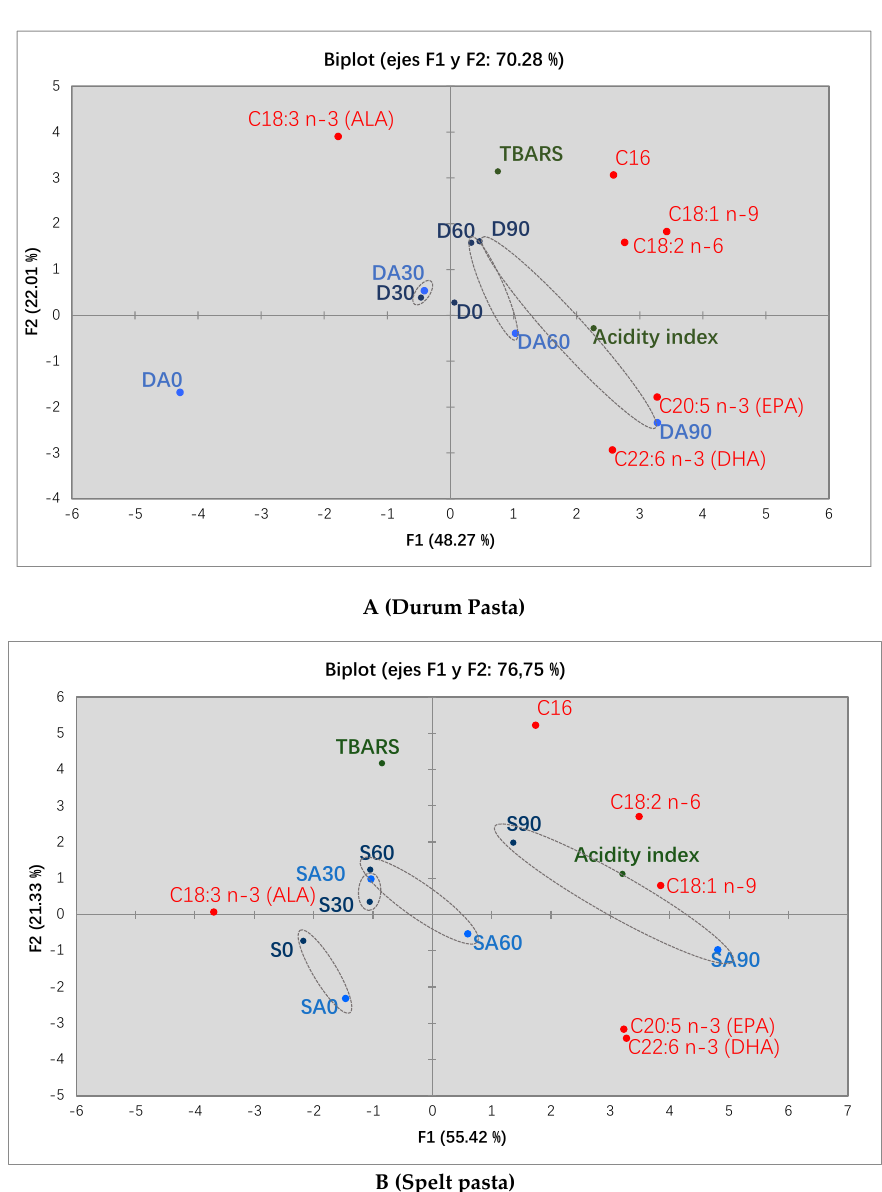
Figure 2. Principal Component: Analysis of developed pasta with and without antioxidant added over storage time. D0: Durum F day 0, D30: Durum F day 30, D60: Durum F day 60; D90: Durum F day 90, DA0: Durum F + antioxidant day 0, DA30: Durum F + antioxidant day 30, DA60: Durum F + antioxidant day 60, DA90: Durum F + antioxidant day 90. S0: Spelt F day 0, S30: Spelt F day 30, S60: Spelt F day 60; S90: Spelt F day 90, SA0: Spelt F + antioxidant day 0, SA30: Spelt F + antioxidant day 30, SA60: Spelt F + antioxidant day 60, SA90: Spelt F + antioxidant day 90. ( A ) Durum Pasta; ( B ) Spelt pasta.